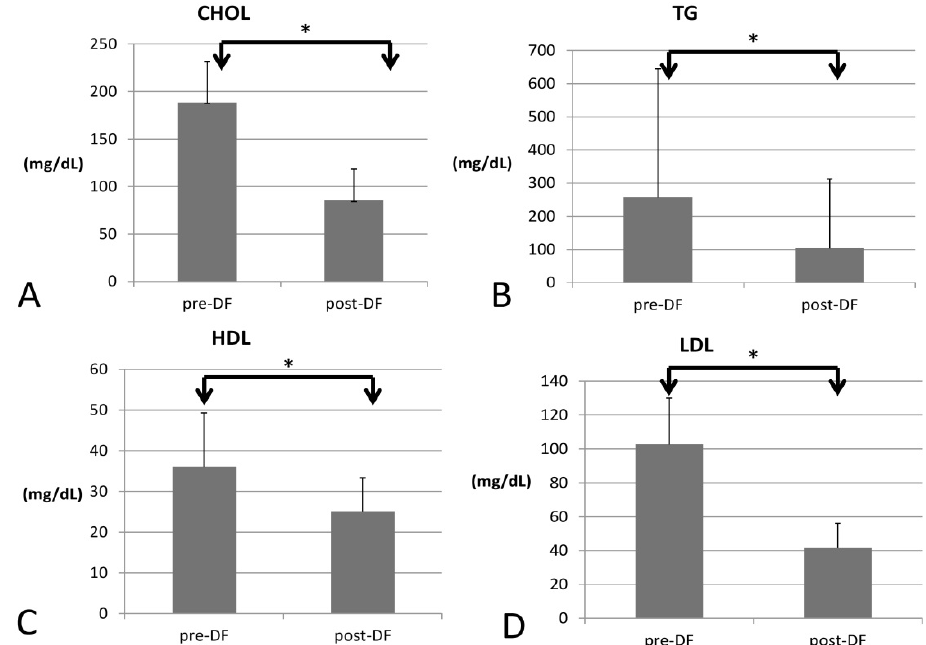
Figure 1. Changes in the lipid profile, including ( A ) total cholesterol (CHOL), ( B ) triglycerides (TG), ( C ) high-density lipoprotein (HDL), and ( D ) low-density lipoprotein (LDL) before and after DF (all showed significant decrease). (* for p < 0.05)